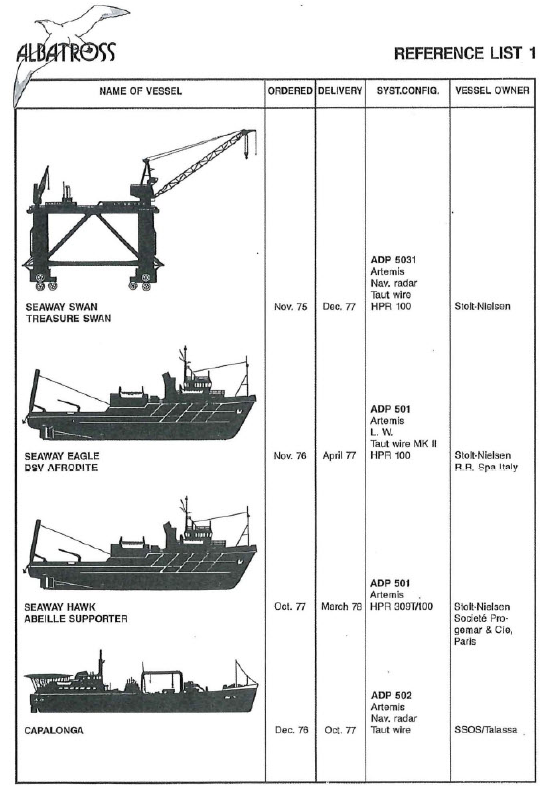
Figure 5: The first page in Albatross’ reference list from 1984, showing all ships that the com- pany had delivered equipment to up to that point. Details about delivery dates, company names and the type of DP system were also included. Illustration: